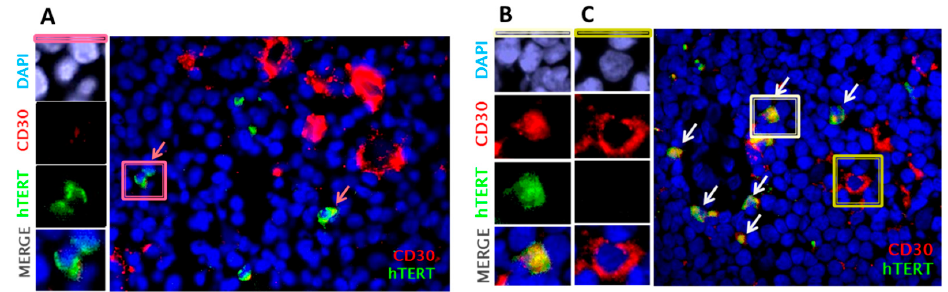
Figure 5. Immunofluorescence analysis of CD30 (red) and hTERT protein (green) of cells in lymph nodes of two different HL patients demonstrate ( A ) the presence of very high levels of hTERT in small cells lacking CD30 (pink arrows), (40× magnification), ( B ) co-localization of hTERT and CD30 expression in Hodgkin cells, (white arrows), and ( C ) the absence of hTERT expression in HRS cells (yellow frame) (40× magnification).